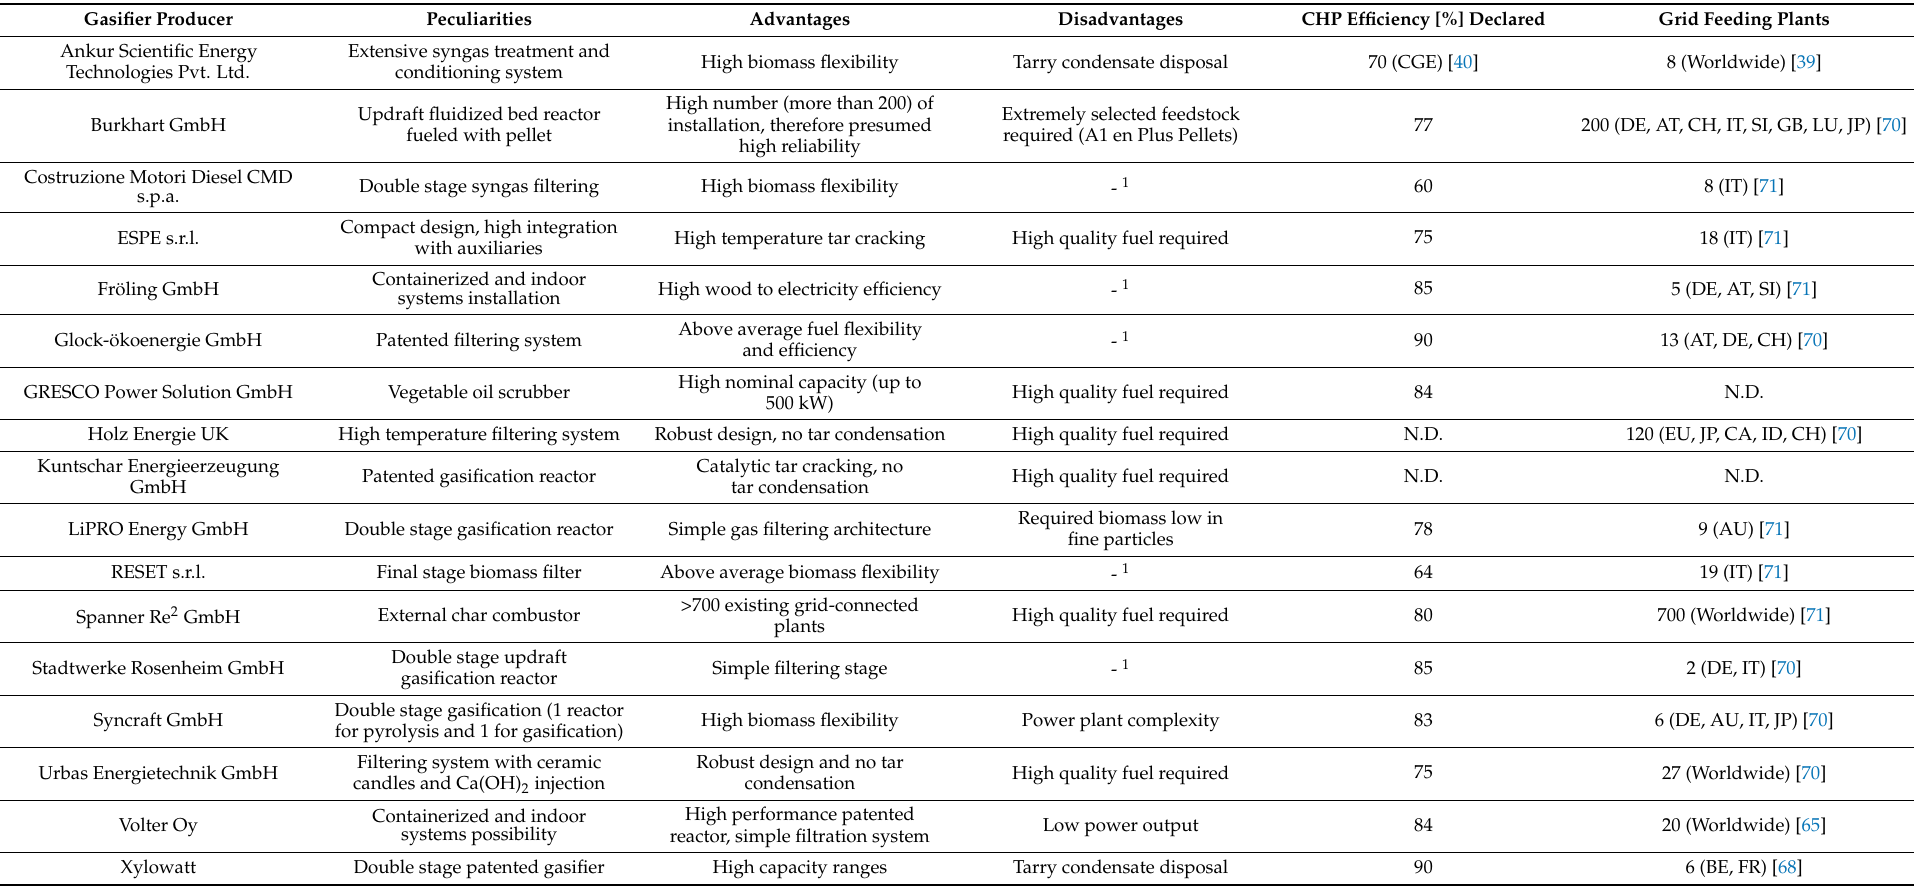
Table 1. Commercial small scale gasification power plants